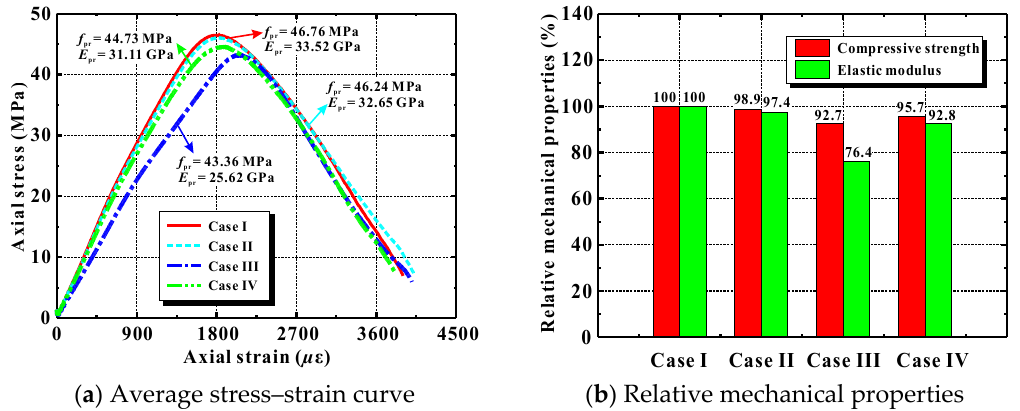
Figure 16. Simulated mechanical performance of various types of concrete in compression.